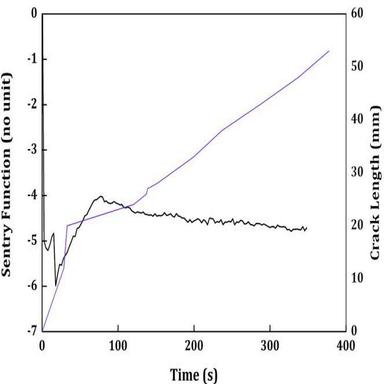
Sentry function and crack length progression for specimen A